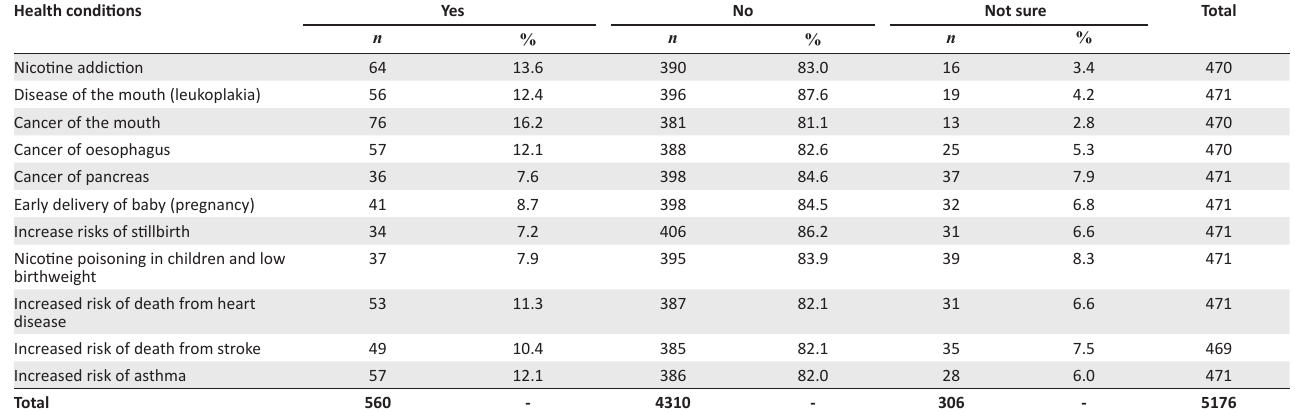
TABLE 2: Health risks associated with smokeless tobacco use. Health